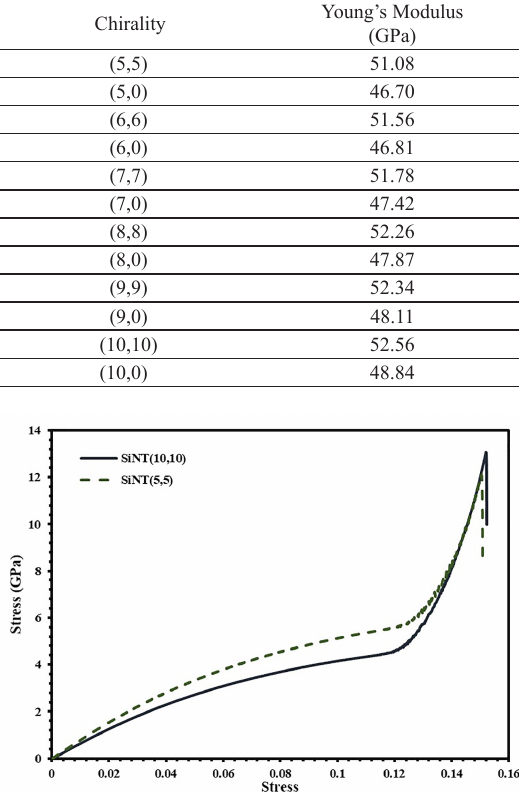
Figure 3. Stress–Strain curve of silicon nanotube armchair (5,5) and (10,10).